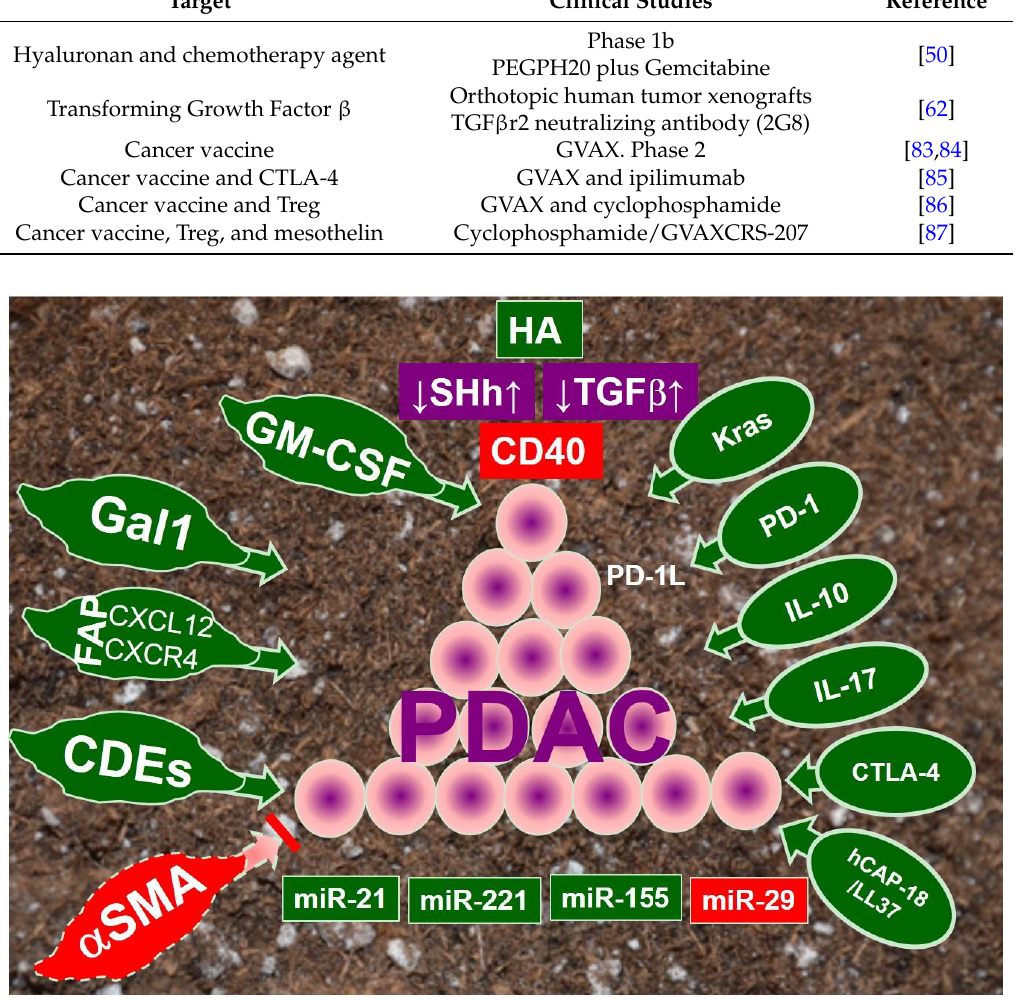
Figure 1. The pleiotropic influence of the tumor microenvironment on pancreatic ductal adenocarcinoma (PDAC). The progression of (PDAC) (pyramid spheres in the center) is controlled by various molecules and signaling pathways in the tumor microenvironment. While molecules associated with carcinoma-associated fibroblasts or pancreatic stellate cells were displayed in spindles at the left side of the figure, others involved with immune cells are presented in ova at the right side of figure. Moreover, the signaling pathways are presented in rectangles above PDAC, while the microRNAs (miR) are underneath. Tumor-promoting factors are shaded in green, while inhibiting factors are in red. Yet, ones shaded in purple are pleotropic, with both promoting and inhibiting effects, depending on the stage of tumors as well as the research studies. The abbreviations used are CDEs (CAFs-derived exosomes); CTLA-4 (cytotoxic T lymphocyte-associated protein 4); FAPa (fibroblast activation protein-a); Gal1 (glycan-binding protein galectin-1); GM-CSF (granulocyte macrophage colony-stimulating factor); HA (hyaluronan); IL-10 (interleukin 10); IL-17 (interleukin 17); Kras (constitutively oncogenic Kras); miR (microRNA); PD-1 (programmed cell death 1 receptor); PD-1L (ligand for PD-1); and SHh (Sonic